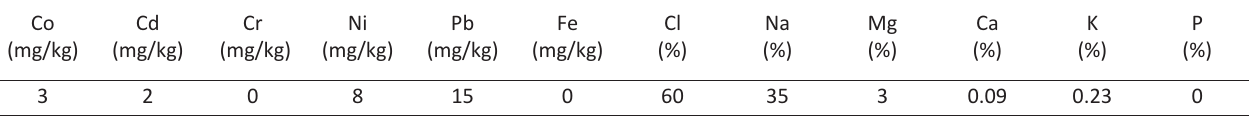
Table 3 ­ Some chemical properties of used lake salt for salinity treatments Co